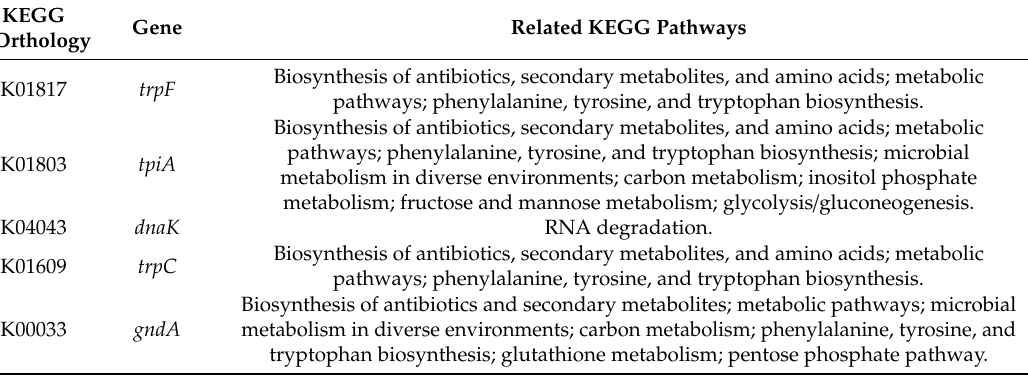
Table 5. Downregulated genes assigned to KEGG metabolic